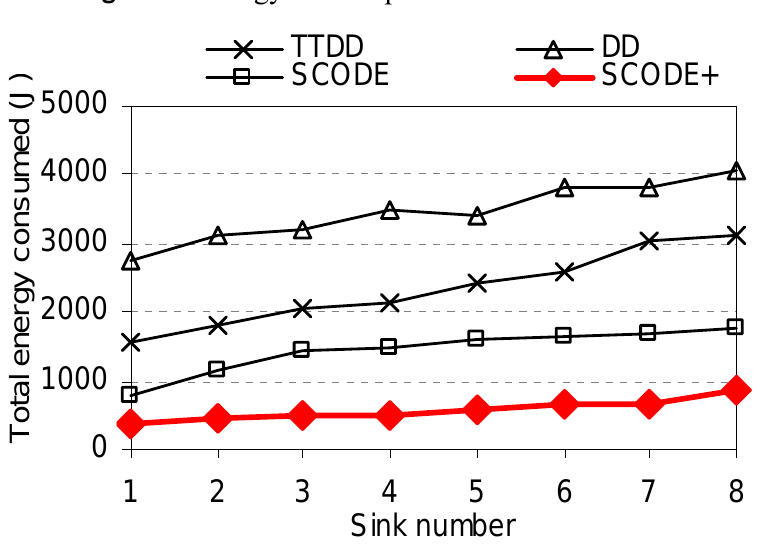
Figure 9 . Energy consumption vs. sink number.